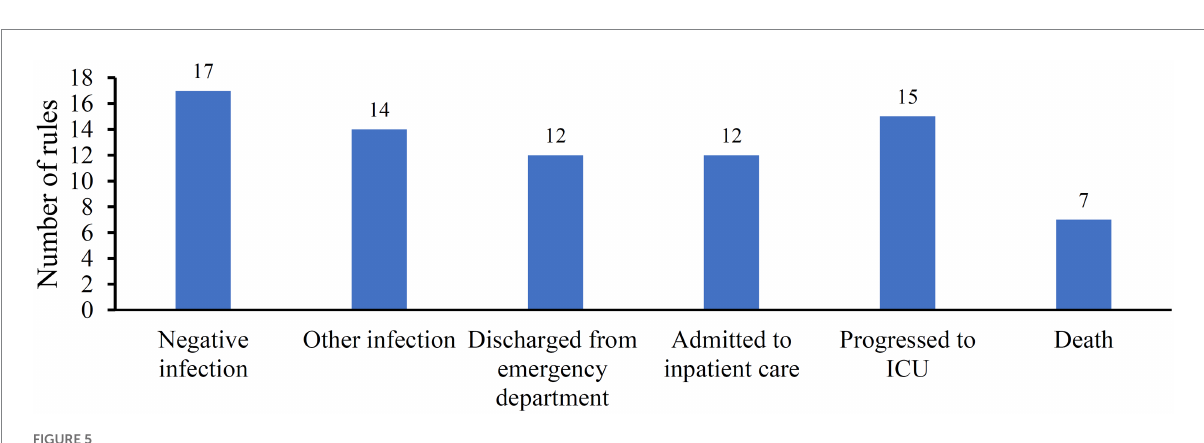
FIGURE 5 Distribution of classification rules on six